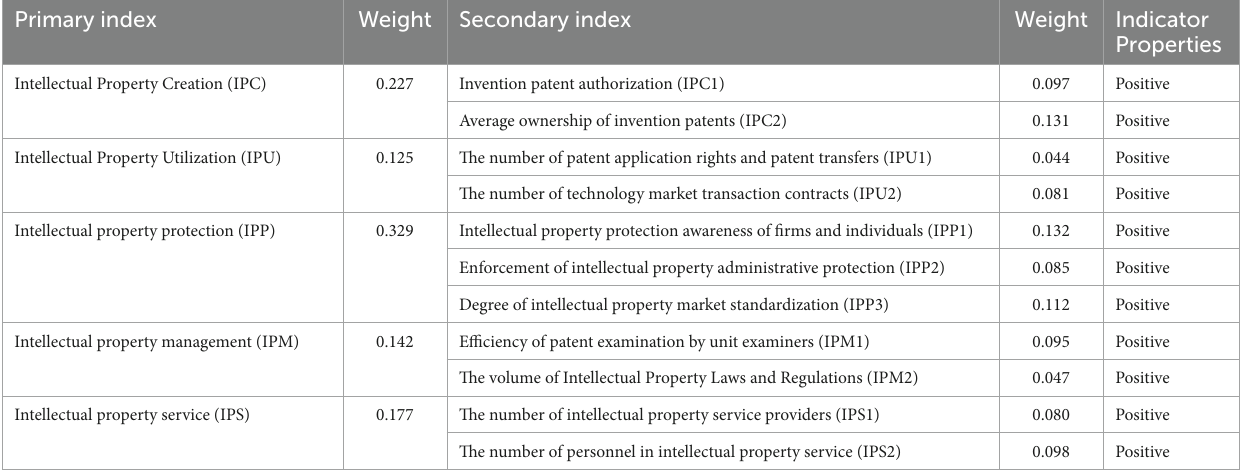
TABLE 1 The whole chain development of intellectual property index